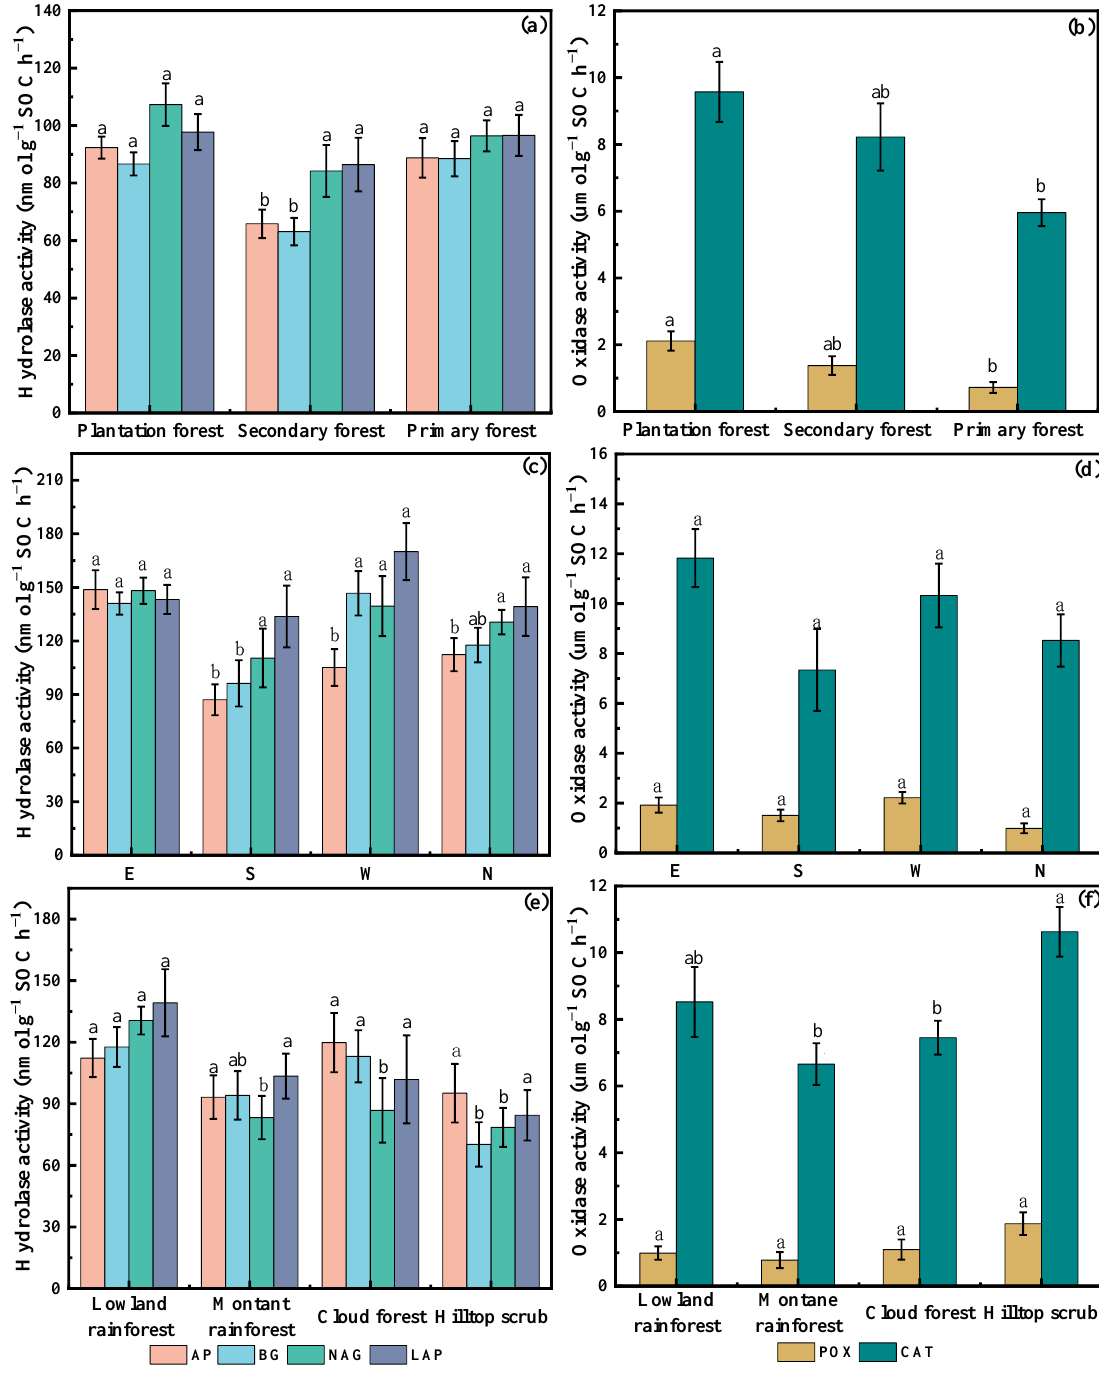
Figure 2. The activity changes of six enzymes in three forest types, four slope orientations, and vegetation types in Wuzhishan National Nature Reserve. ( a , c , e ) represent the enzyme activities of the four hydrolases in three forest types, four slope orientations, and four vegetation types, respectively. ( b , d , f ) represent the enzyme activities of the two oxidases in three forest types, four slope orientations, and four vegetation types, respectively. Different lowercase letters indicate significant difference of the same enzyme activity in different soil types ( p < 0.05). The vertical black line represents the standard error.